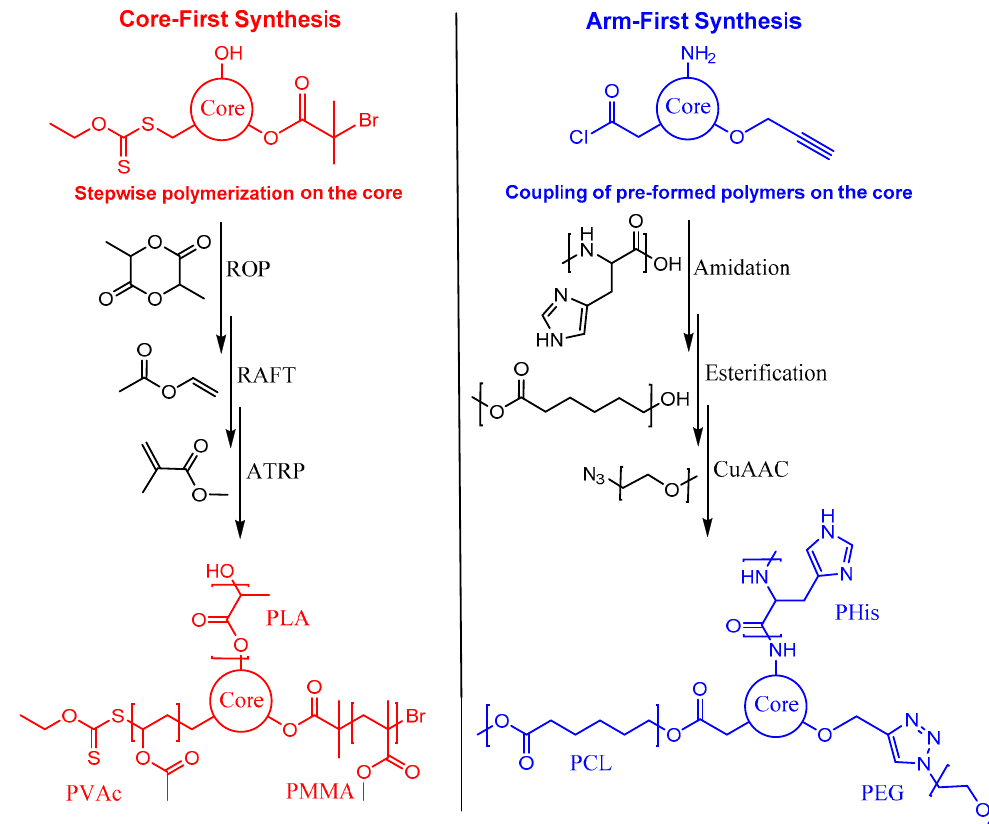
Figure 2. Examples of core-first synthesis ( left ) and arm-first synthesis ( right ) with examples of functionalities, monomers, and polymers.